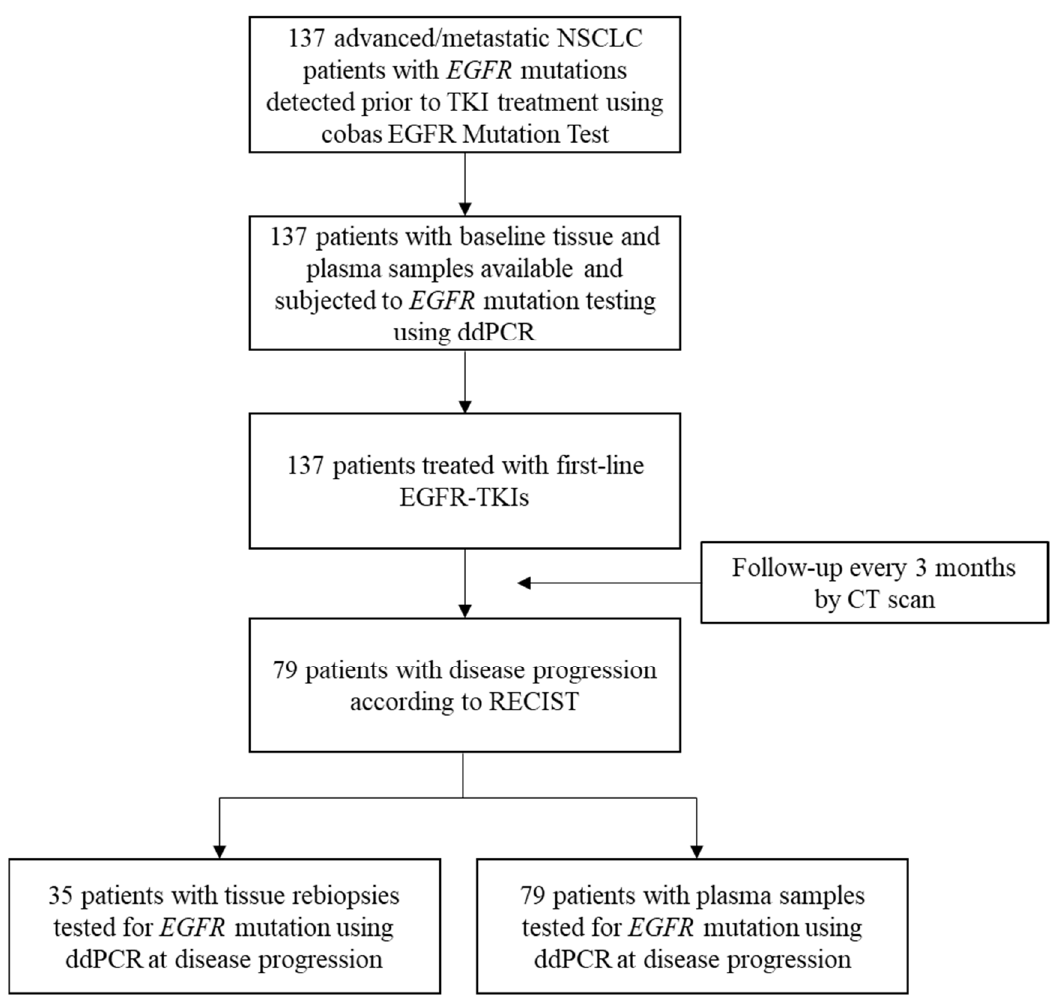
Figure 4. Flow diagram of the study population. NSCLC, non-small cell lung cancer; ddPCR, droplet digital polymerase chain reaction; CT, computed tomography.